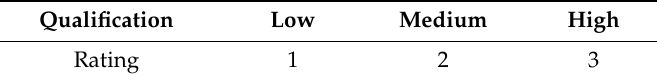
Table 1. Rating of the criteria for the scoring experts.